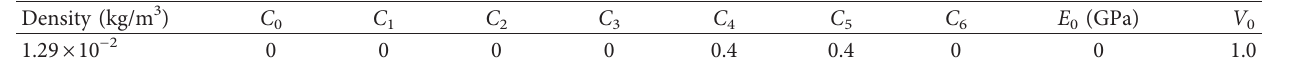
Table 5: Material and state equation parameters of the air